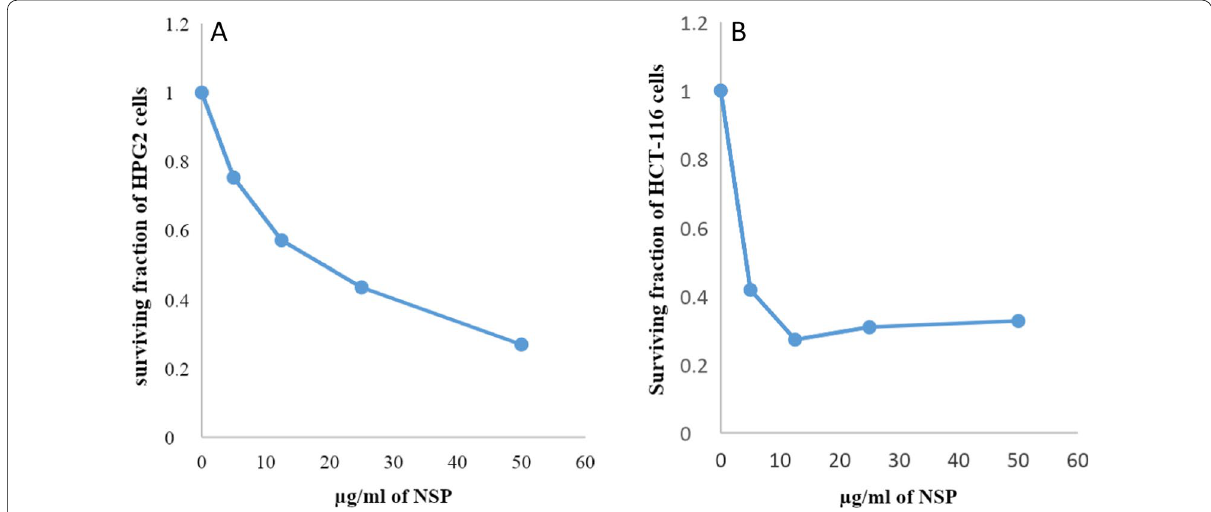
Fig. 1 Cytotoxicity effect of N. septemcrenata on human cell line of human cell line of HepG2 and HCT‑116